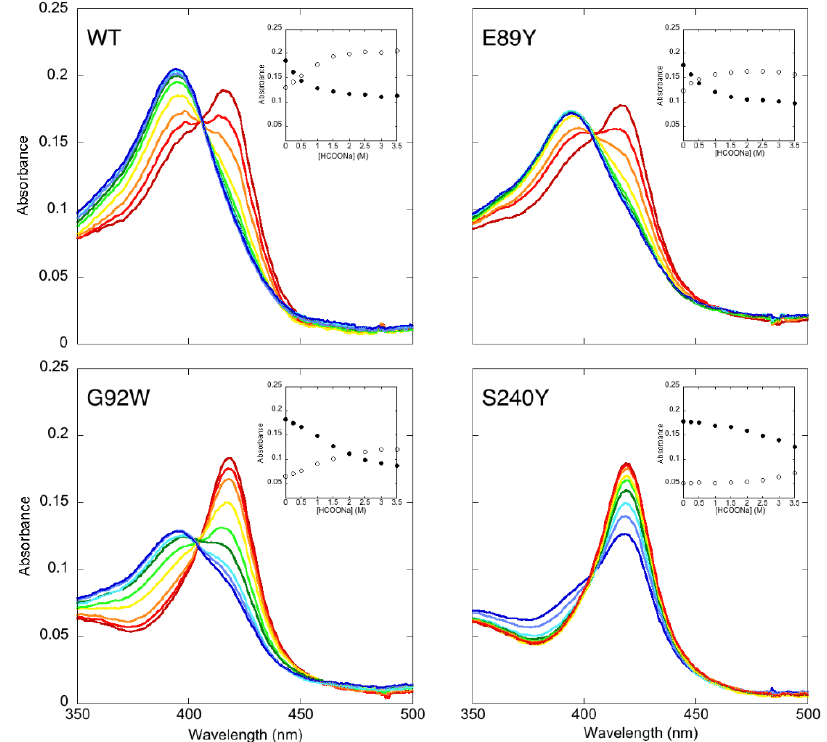
Figure 5. Effect of the ionic strength on the spin-state equilibrium in OleP mutants bound to 6DEB. UV-visible absorption spectra of OleP WT (2 µM) and mutants (1.5 µM) in the presence of 150 µM 6DEB collected upon addition of increasing concentration of sodium formate at 298 K, in 50 mM Hepes, and 200 mM NaCl, pH 7.5. Rainbow colors indicate the direction of the absorption changes observed changing from 0 (dark red) to 3.5 M (blue) sodium formate (light red = 0.25 M, orange = 0.5 M, yellow = 1 M, light green = 1.5 M, dark green = 2 M, cyan = 2.5 M, purple = 3 M). Relative insets: Absorbance intensities of OleP WT and mutants bound to 6DEB as a function of total sodium formate concentration are reported. Data refer to the absorbance monitored at 419 nm (full dots) and at 387 nm (empty dots). OleP wild type binding data are taken from [10].